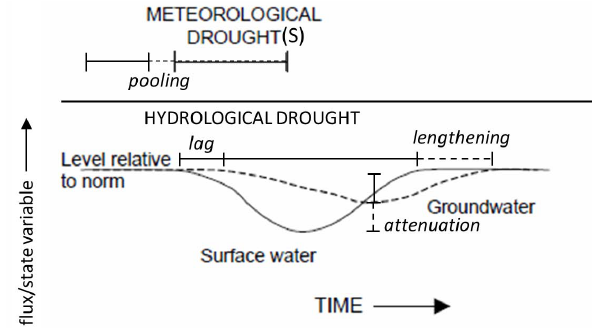
Fig. 1. Features characterising propagation of meteorological drought(s) to hydrological drought: pooling, lag, attenuation, and lengthening (modified from Hisdal and Tallaksen,